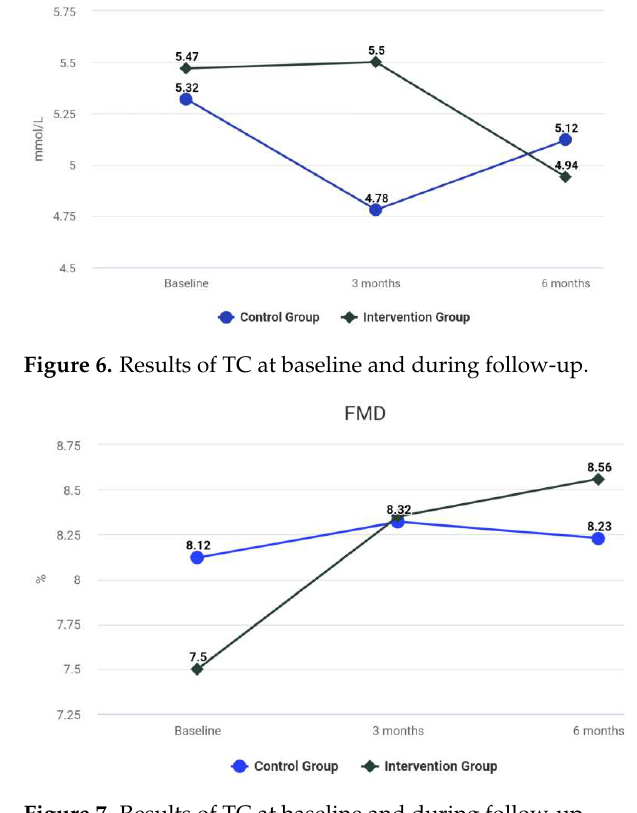
Figure 6. Results of hs-CRP at baseline and during follow-up. Table 4. MANCOVA Results. Source